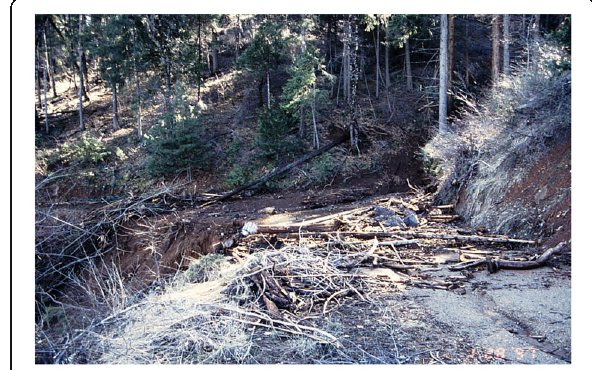
Fig. 5 The flow path of the Pilot Ridge debris flow where it crossed Forest Road 1S66. Note the levees of soil and transported trees left on the road and the undermining of the roadbed by the debris flow ’ s passage